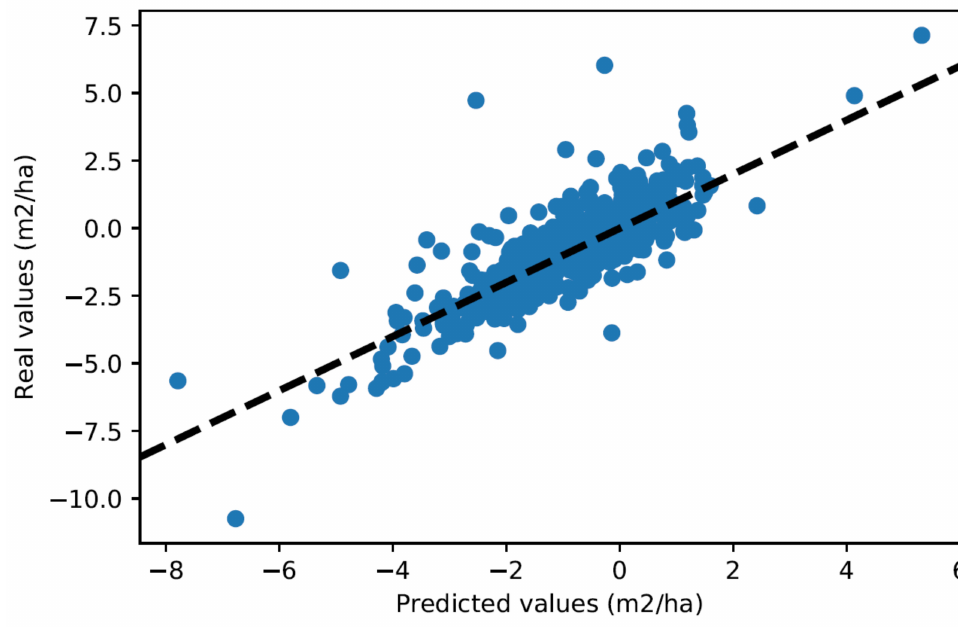
Figure 14. Residuals plot for ∆ G predictions at the level of couples (division, inventory year) for the small woods class.